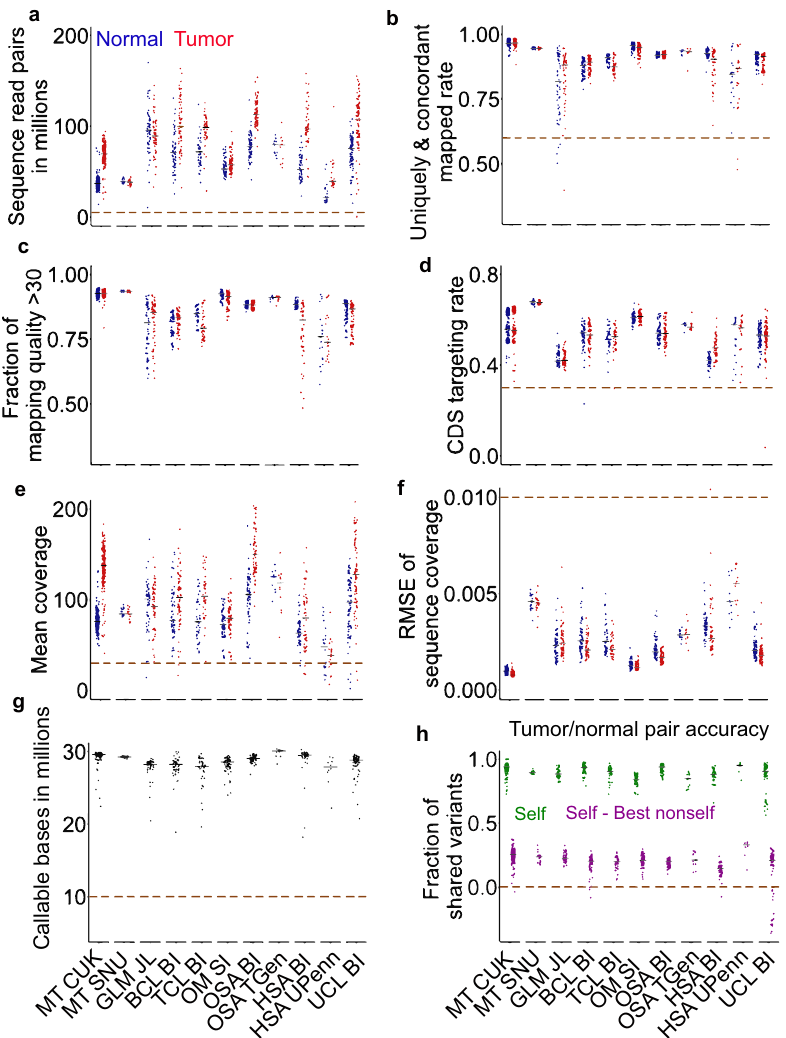
Fig. 1 We performed a rigorous quality control (QC) of whole-exome sequencing (WES) data published for 654 canine cases. a Distributions of total read pairs per sample of the tumor and normal sample sets of each study. Each dot represents a sample and the median is indicated by a black line. The dashed line speci fi es the QC cutoff. Each study is represented by the tumor type and the institute name. MT mammary tumor, GLM glioma, BCL B-cell lymphoma, TCL T-cell lymphoma, OM oral melanoma, OSA osteosarcoma, HSA hemangiosarcoma, UCL unclassi fi ed. CUK Catholic University of Korea, SNU Seoul National University, JL Jackson Laboratory, SI Sanger Institute, BI Broad Institute, TGen Translational Genomics Research Institute, UPenn University of Pennsylvania. n = 184, 20, 56, 61, 39, 65 (71 tumors), 66, 12, 47, 21 (23 tumors), and 83 independent cases for matched normal and tumors samples for each independent study listed from left to right. b – f Distributions of per sample rate of read pairs that aligned concordantly and uniquely to the canFam3 reference genome ( b ) ( n = 81 for UCL BI; others the same as a ), the fraction of reads with mapping quality of ≥ 30 ( c ) ( n = 50 and 18 for GLM JL and HSA UPenn respectively; others the same as b ), CDS-targeting rate (the fraction of read pairs that align concordantly and uniquely to the canFam3 CDS regions) ( d ) (the same sample size as c ), mean read coverage in CDS regions ( e ) ( n = 60, 38 and 80 for BCL BI, TCL BI, and UCL BI, respectively; others the same as d ) and root-mean-square error (RMSE) between the actual distribution and theoretical distribution (based on the Poisson distribution) of sequence coverage in CDS regions ( f ) ( n = 183, 49, 58, 43, 8, and 74 for MT CUK, GLM JL, BCL BI, HSA BI, HSA UPenn, and UCL BI, respectively; others the same as e ). g Distributions of the total number of callable bases per case, determined by MuTect. n = 183, 20, 49, 58, 38, 71, 66, 12, 42, 8, and 74 independent tumors from left to right. h Tumor-normal pairing accuracy. “ Self ” (in green) is the fraction of germline variants shared between the normal and tumor samples of a dog. “ Best nonself ” is the fraction of germline variants shared between a normal or tumor sample of one dog and its best-matched sample from another dog. “ Self — Best nonself ” (in purple) indicates the difference and a negative difference points to incorrect tumor-normal pairing. The sample size is the same as in ( g ). Source data are provided as a Source Data fi